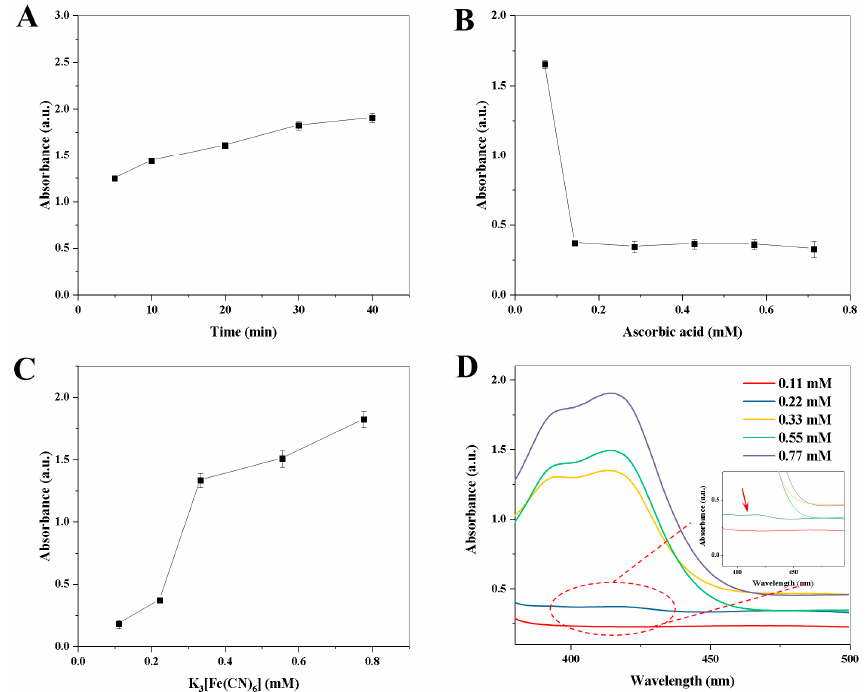
Figure 4. Effects of enzymatic reaction time ( A ) and ascorbic acid concentration ( B ) on the absorbance value at 412 nm.; Effect of K 3 [Fe(CN) 6 ] concentration on the absorbance value at 412 nm ( C ), and the corresponding UV–Vis absorption spectra ( D ). Error bars represent standard deviations ( n = 3).